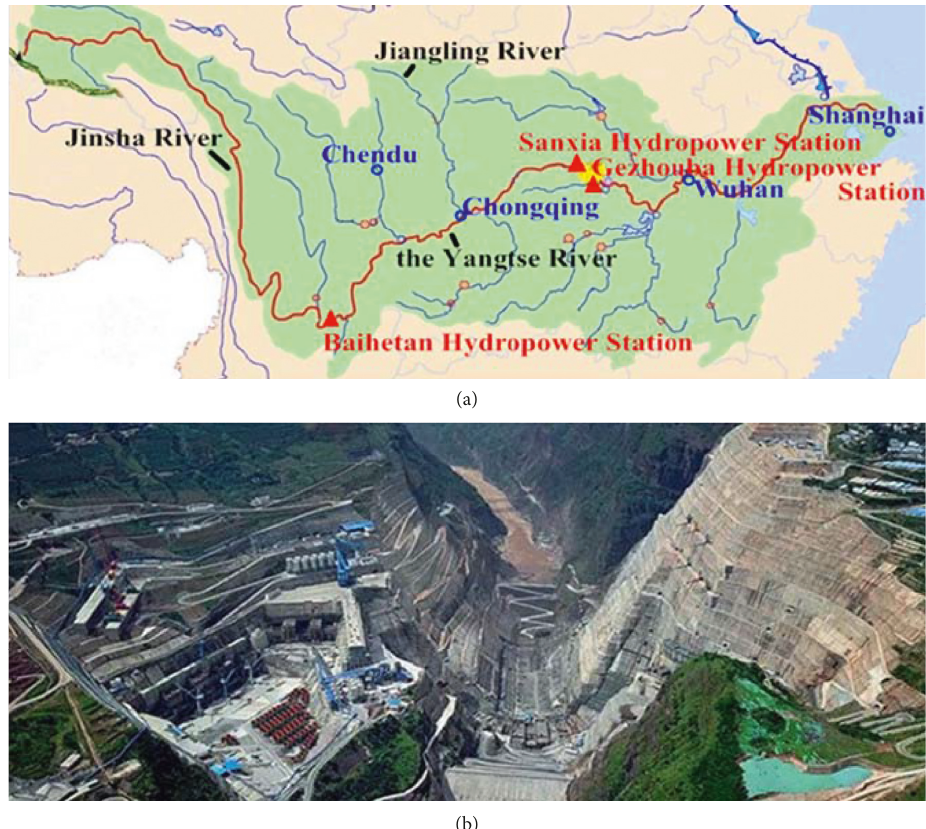
Figure 1: Aerial view (a) and location map (b) of the Baihetan Hydropower